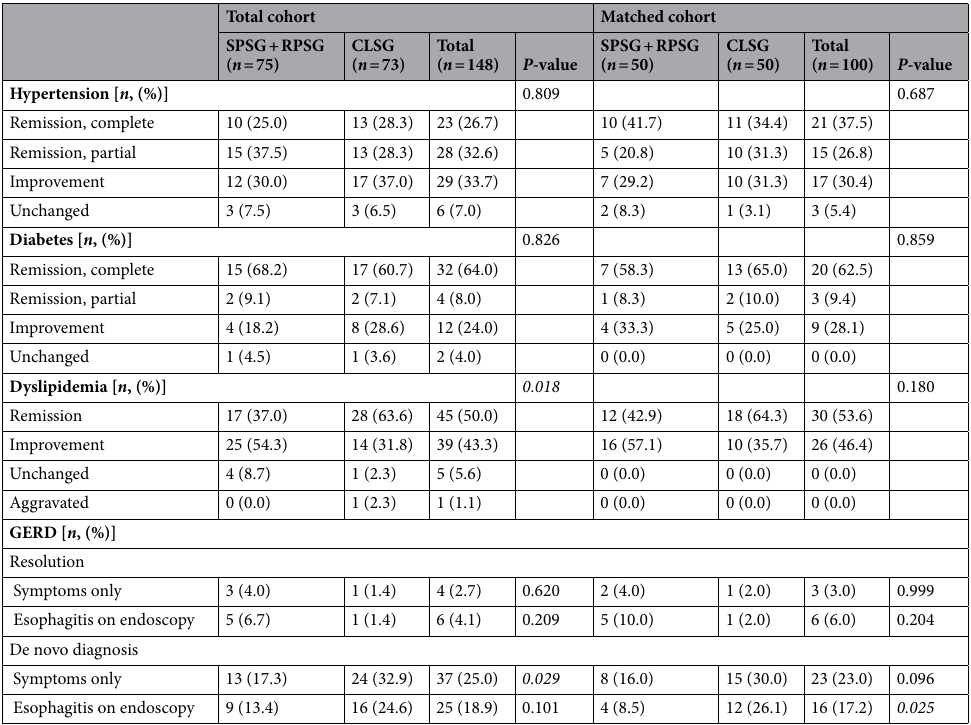
Table 7. Resolution of comorbidities in the total and propensity score-matched cohorts. Significant values are italics. SPSG single-port sleeve gastrectomy, RPSG reduced port sleeve gastrectomy, CLSG conventional laparoscopic sleeve gastrectomy, GERD gastroesophageal reflux